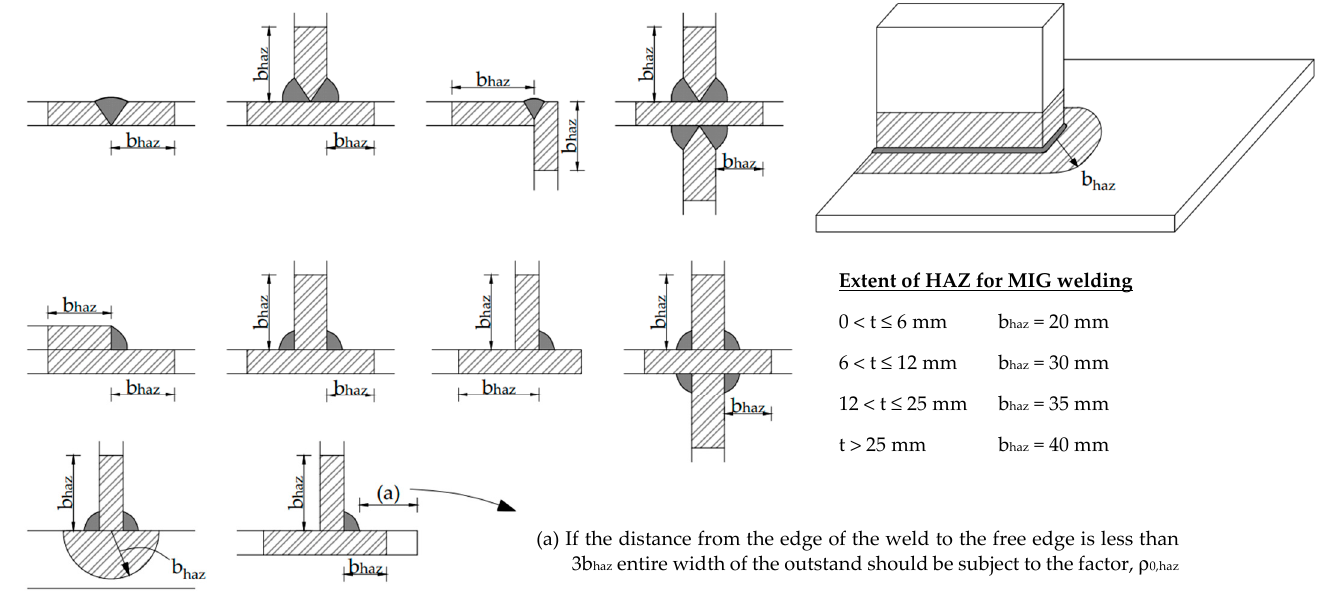
Figure 1. Extent of HAZ according to EC9 [7,9].